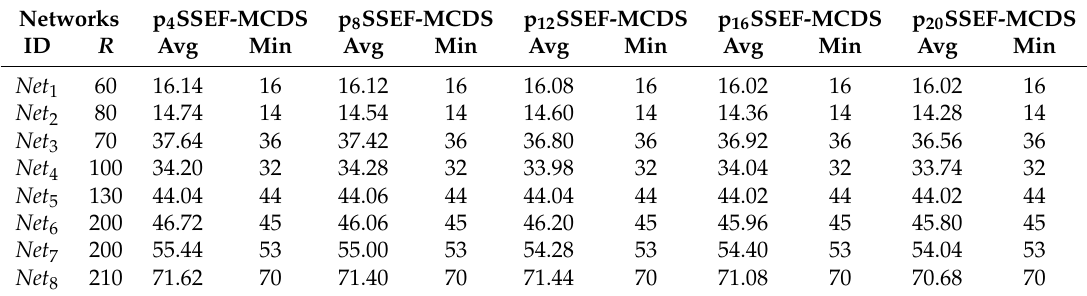
Figure 11. Parallel performance of the pSSEF with Net 2 80, Net 4 100, Net 6 200 and Net 8 210. Table 3. Comparison results for network